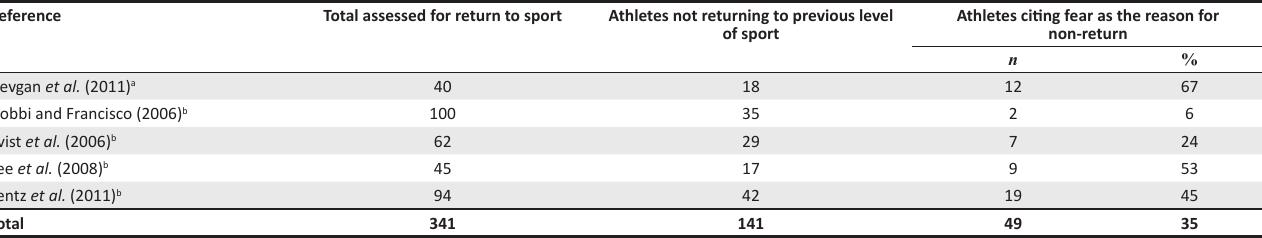
TABLE 3: Summary of studies investigating fear as the reason for not returning to their previous level of sport.